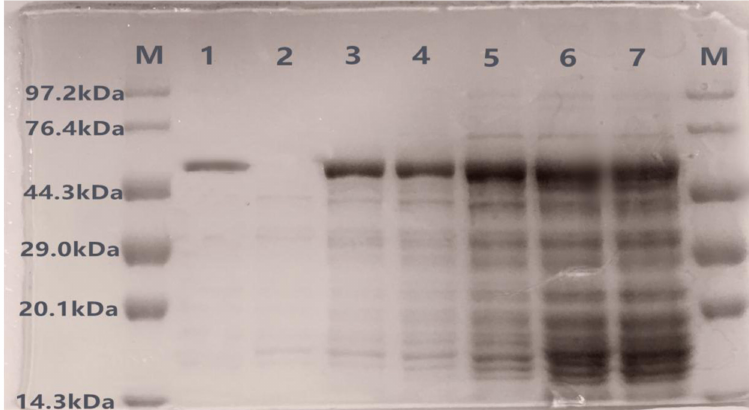
Figure 3. SDS-PAGE confirmation of recombinant protein X33-Lac-2. Lane ‘M’ is the protein maker. Lane 1 is purified recombinant laccase; lane 2 is empty vector ‘X33-pGAPZ α A’; lane 3–7 are the protein expression band of 12 h, 24 h, 36 h, 48 h, and 60 h,